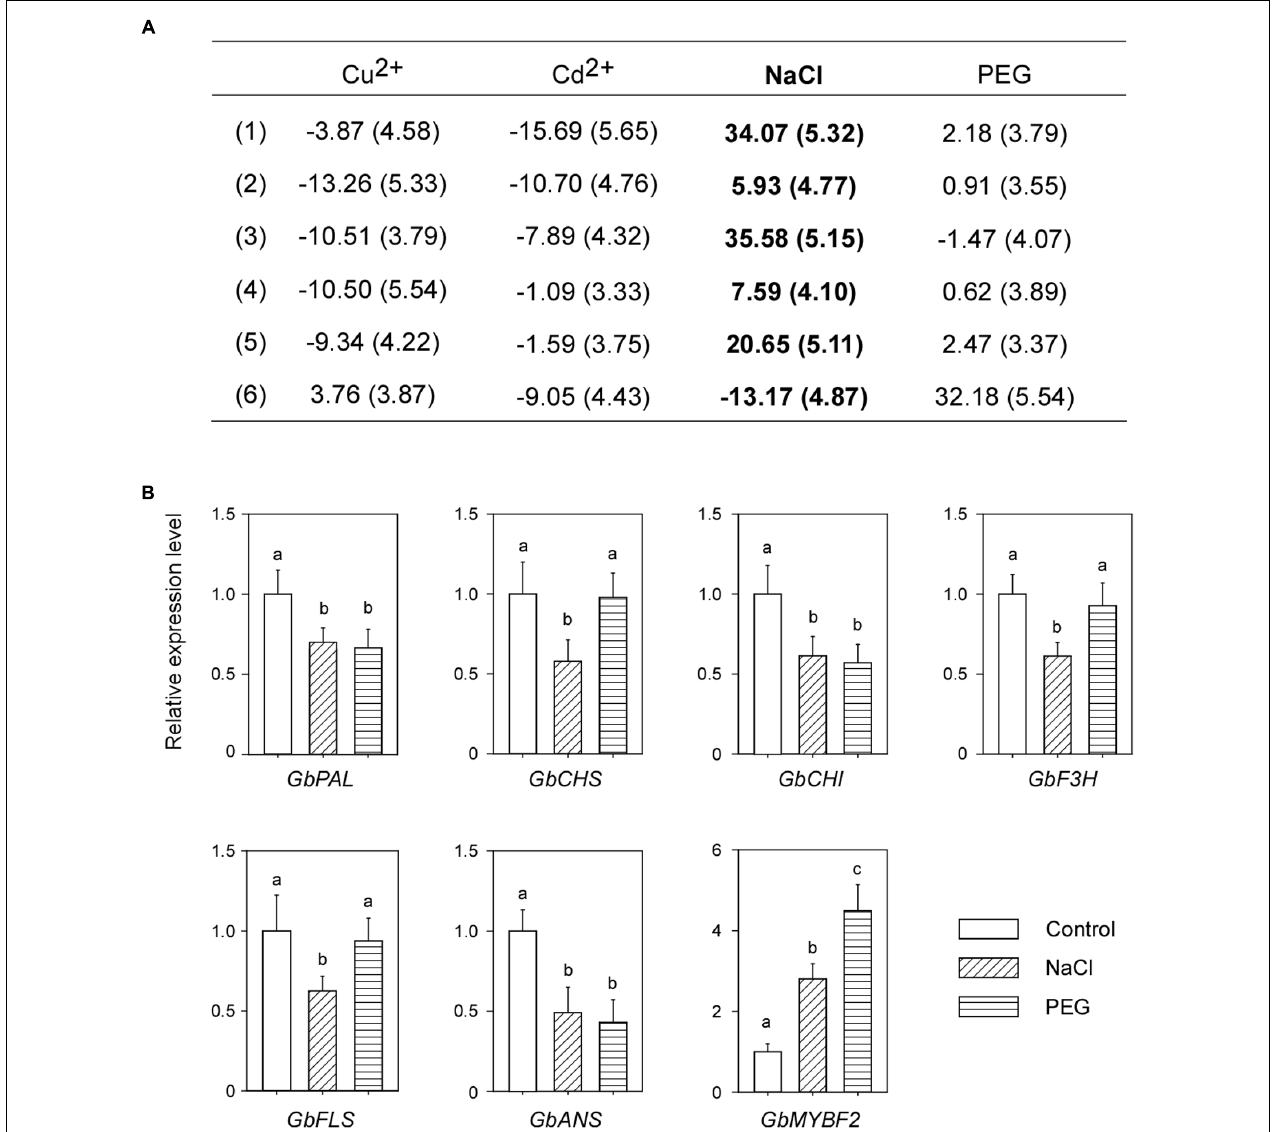
FIGURE 3 | NaCl treatment induces the accumulation of flavonoids and suppresses the expression of corresponding genes in post-harvest Ginkgo leaves. (A) Changes in relative flavonoid contents after various treatments. Six main peaks are analyzed, the SD values are in brackets, and the changes after NaCl treatment are shown in bold. (B) Relative expression levels of flavonoid synthesis related genes after NaCl stress treatment. Different letters indicate significant differences ( P < 0.01; Student’s t -test). Data for independent experiments are shown (mean ± SD; n =